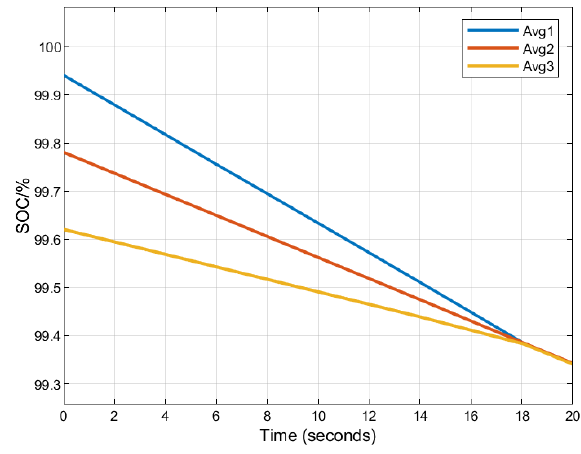
Figure 14. Equalization process of outer layer.